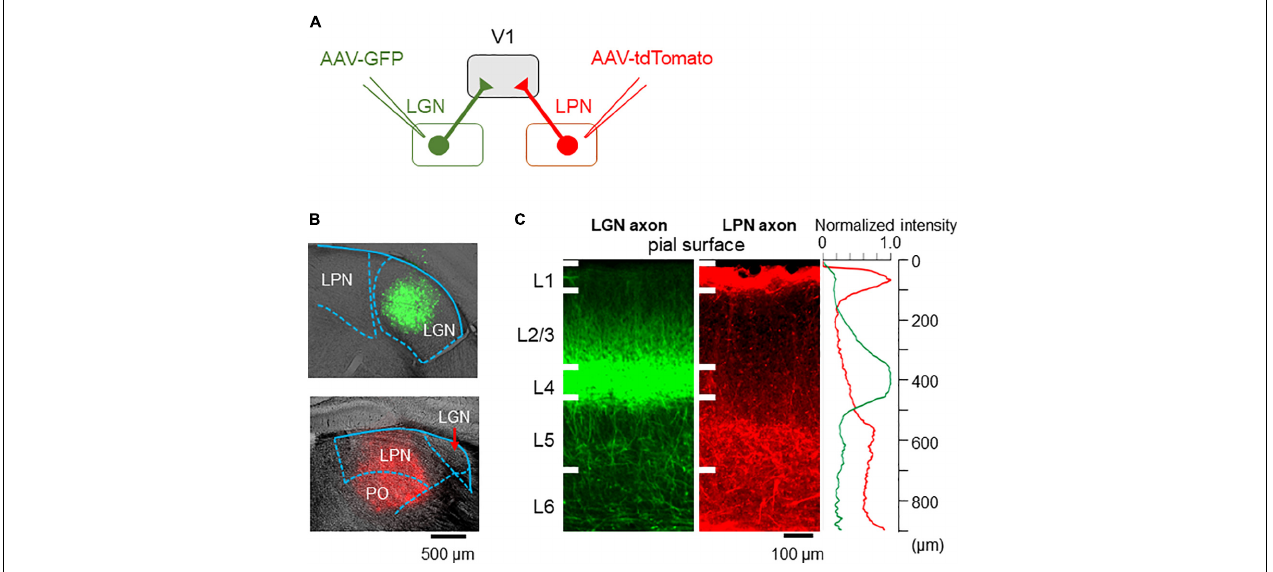
FIGURE 2 | Axonal projections from the LPN and LGN in V1. (A) An anterograde labeling of the LGN and LPN axons with different fluorescent proteins. (B) A local injection of AAV-GFP in the LGN (upper) and AAV-tdTomato in the LPN (lower). (C) The distribution of the LGN (left) and LPN (middle) axons in V1 of the coronal slice. LGN axons project mainly to the layer 4, while LPN axons project mainly to the layer 1 (right). LPN, lateral posterior nucleus; LGN, lateral geniculate nucleus; V1, primary visual cortex; AAV-GFP, adeno-associated virus-green fluorescent